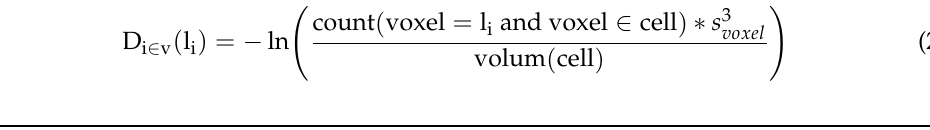
Algorithm 4. Space partition.